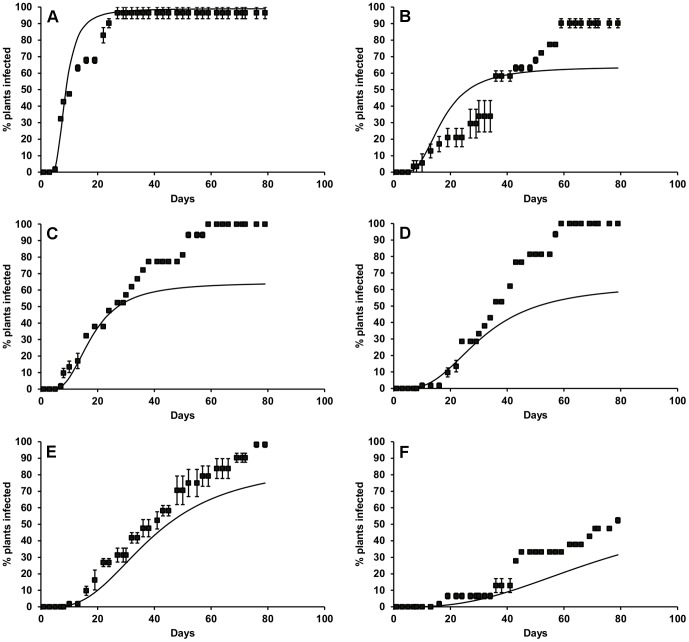
Observed and modelled S. sclerotiorum disease development in lettuce at A) 100% RH, 20°C (RMSE = 23.3) and 60% RH at B) 25°C (RMSE = 61.6), C) 20°C (RMSE = 19.7), D) 15°C (RMSE = 100.8), E) 10°C (RMSE = 53.0) and F) 7°C (RMSE = 116.5).Points represent observed data, lines represent model. Error bars are the standard error of the mean (three replicates).